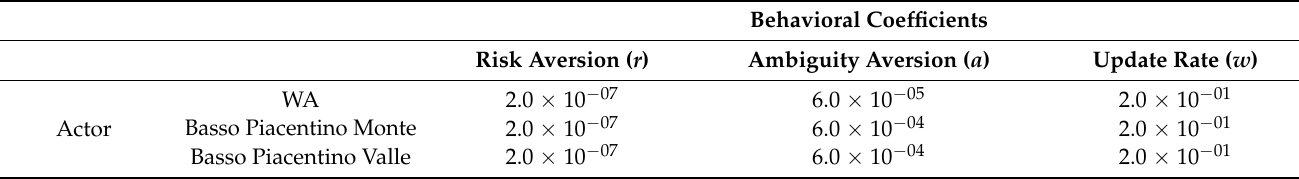
Table 3. Actors’ behavioral coefficients in Scenario 1.